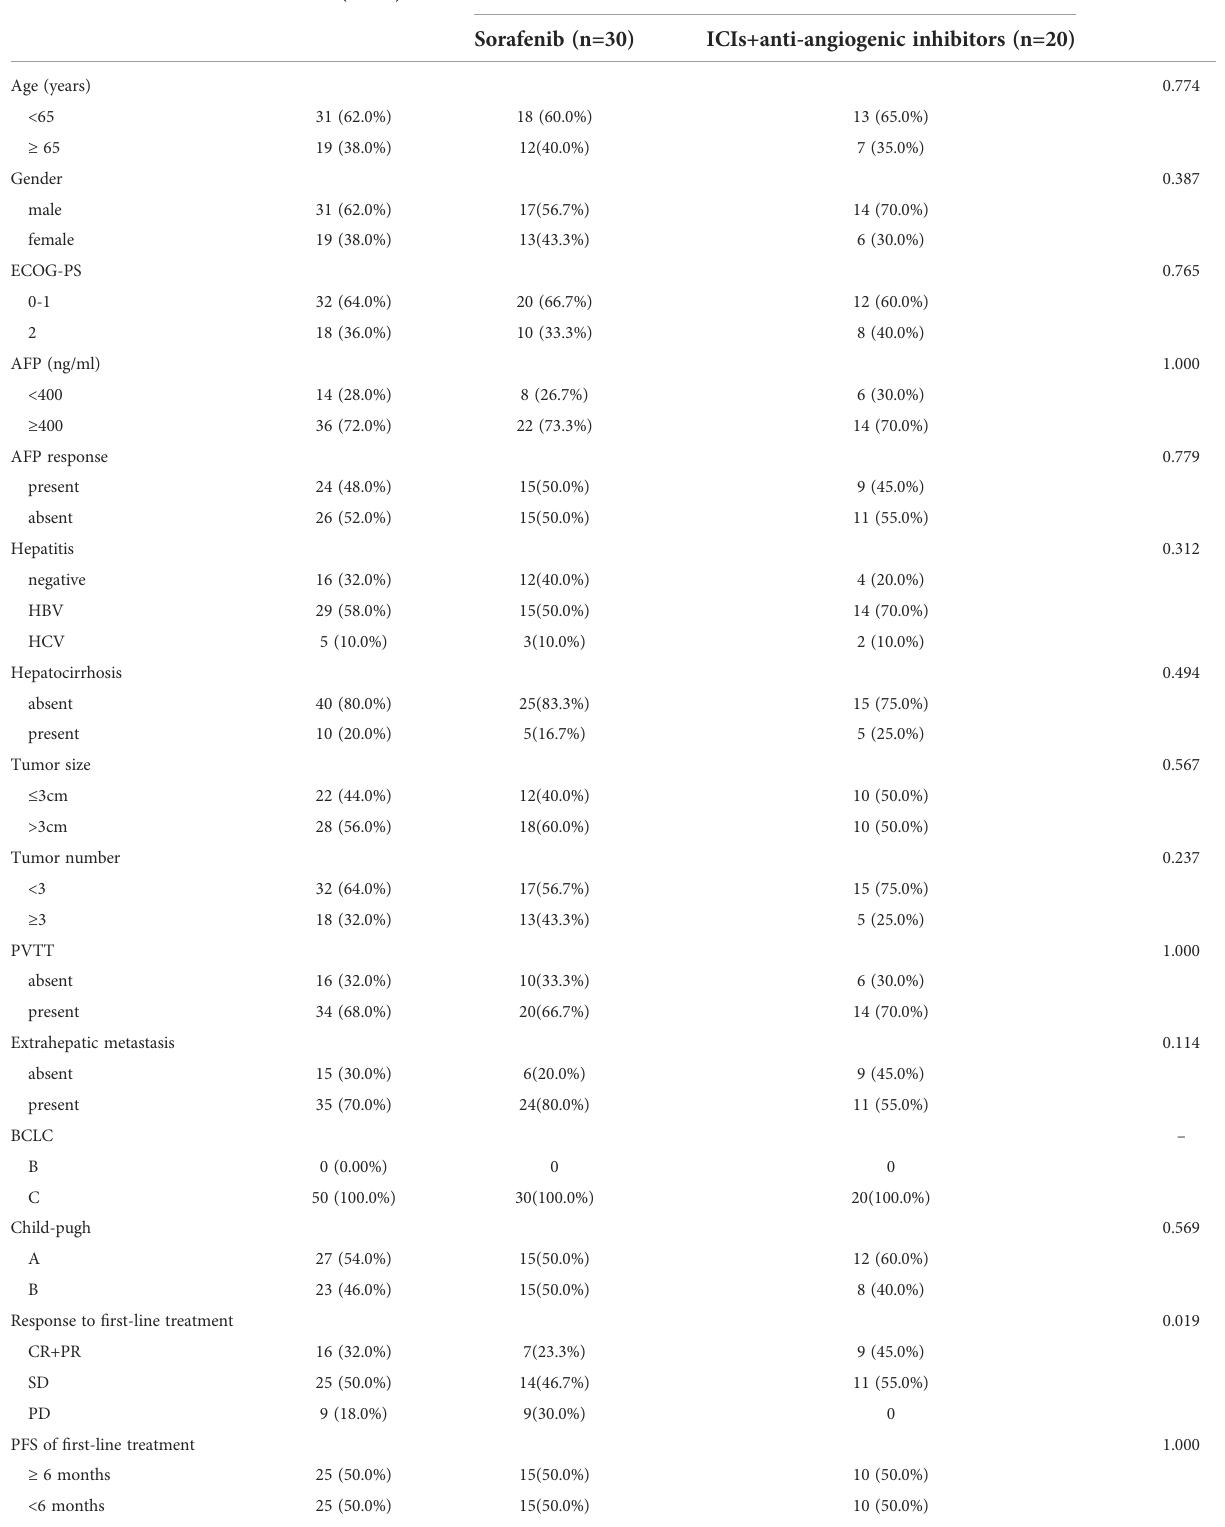
TABLE 1 Clinical characteristics in the 50 patients with unresectable HCC who received lenvatinib as second-line treatment.